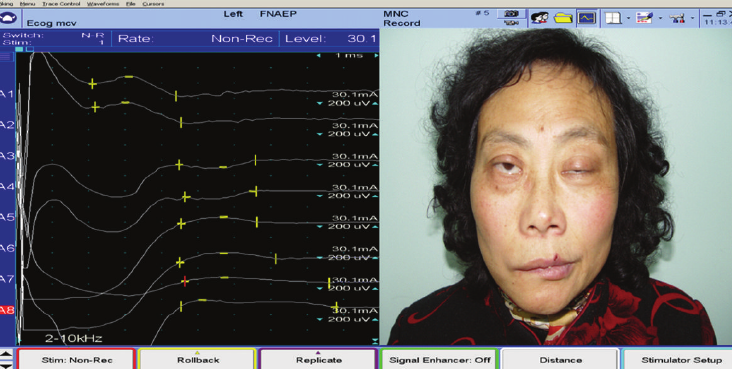
Figure 2: The waveform of FNAEP. A1–A4 show the recorders of asympotomatic side; A5–A8, which amplitude decreased (arrow), show the recorders of sympotomatic side.